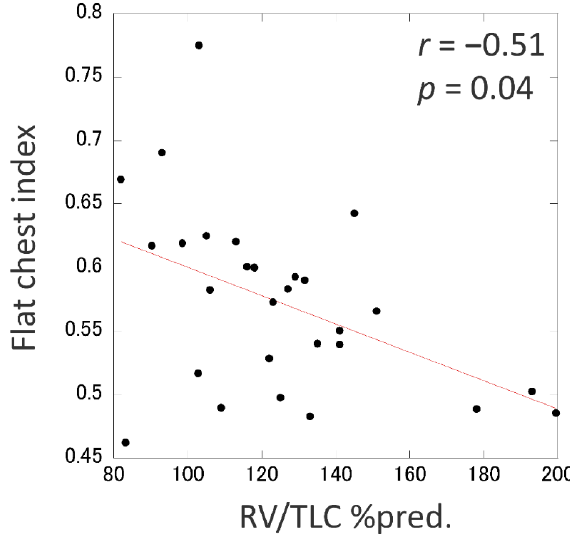
Figure 4. The flat chest index was inversely and significantly correlated with the percentage of the predicted value of the residual volume/total lung capacity (RV/TLC % pred.). Based on the equation of “flat chest index = −0.00111 × (RV/TLC % pred.) + 0.711” derived from a simple linear regression analysis, the cut-o ff values of RV / TLC %pred. (80 and 115) were considered to correspond to those of the flat chest index (0.62 and 0.58,